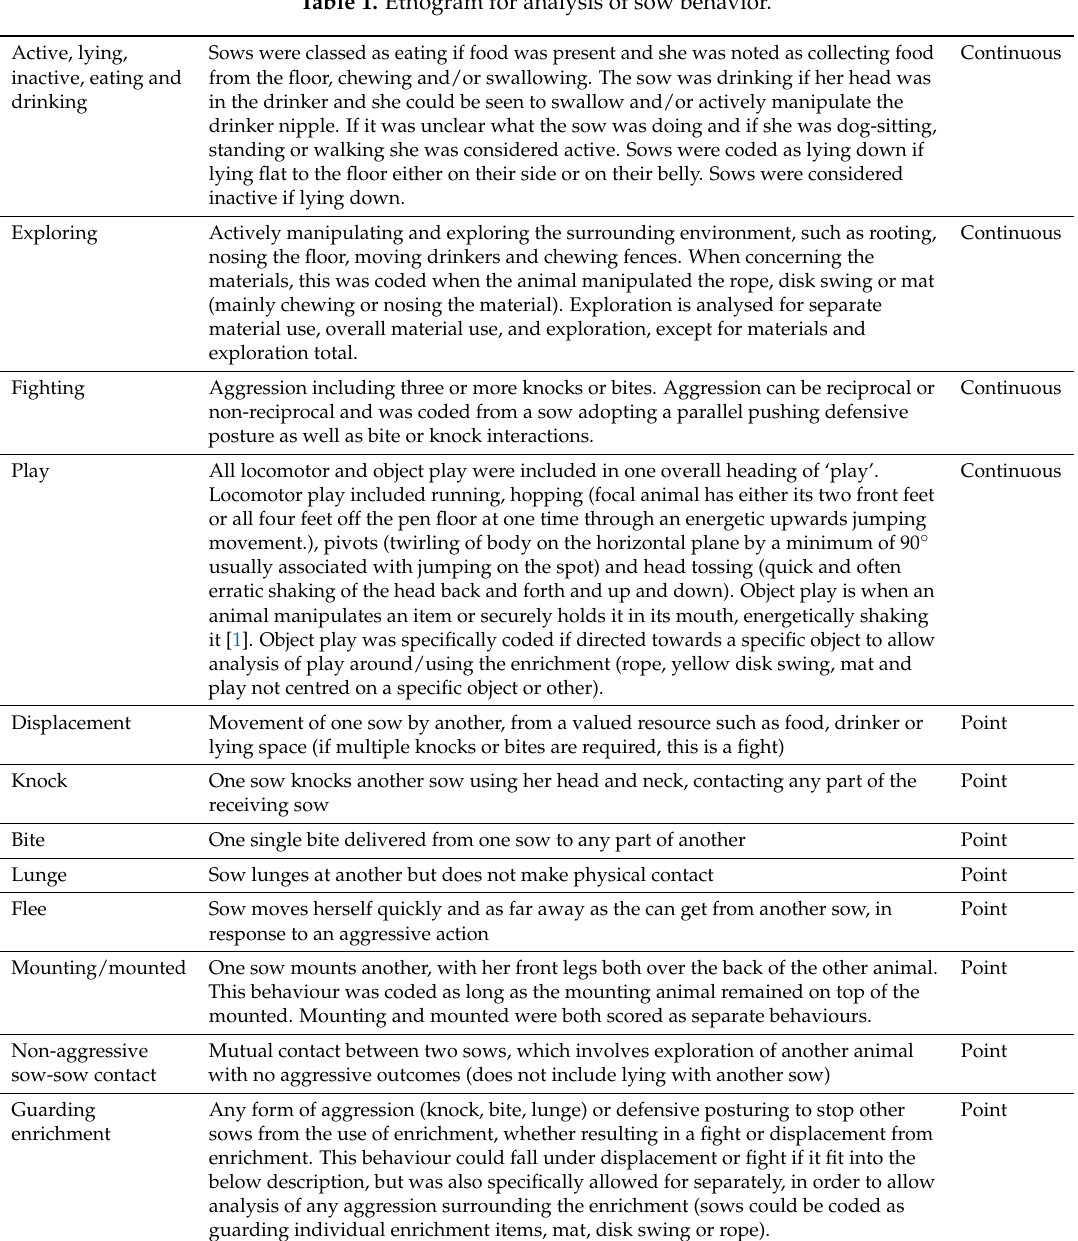
Table 1. Ethogram for analysis of sow